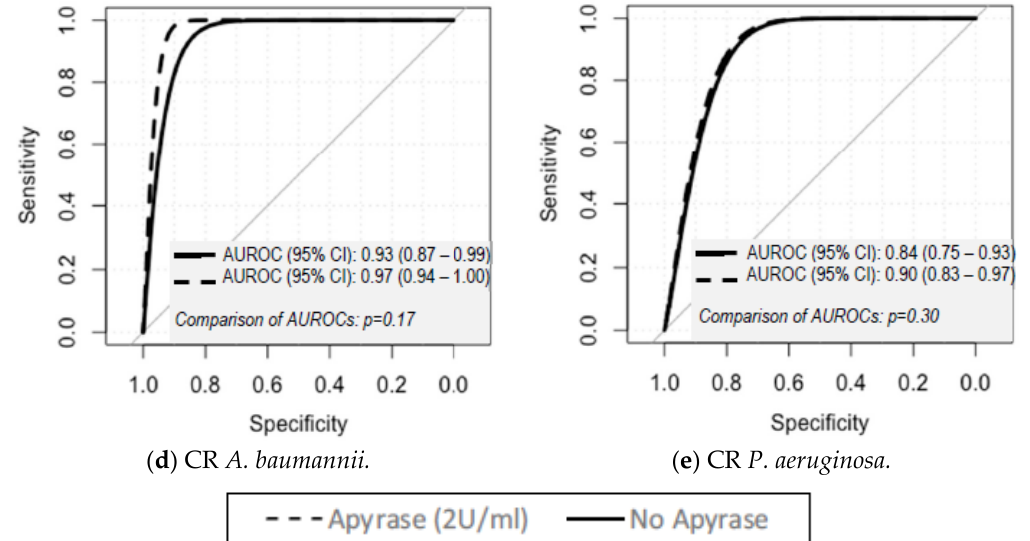
Figure 3. ROC plots for distinguishing between bactericidal and non-bactericidal activity at different timepoints for ( a ) All CR-GNB, ( b ) CR E. coli , ( c ) CR Klebsiella spp., ( d ) CR A. baumannii , and ( e ) CR P. aeruginosa with and without apyrase (2 U/mL) in 24 h TKSs.